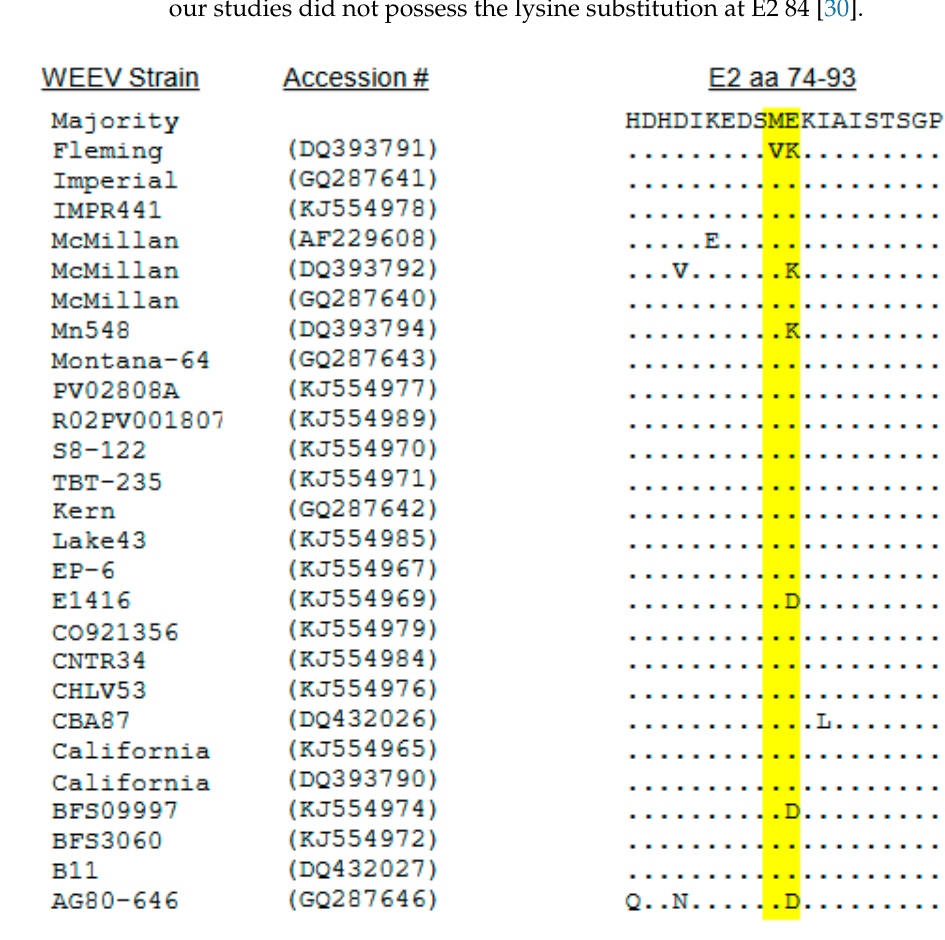
Figure 3. Alignment of the differences between WEEV Fleming and other WEEV strains in the E2 70 region illustrating amino acid sequence differences tested for effects upon HS dependent infectivity (yellow).